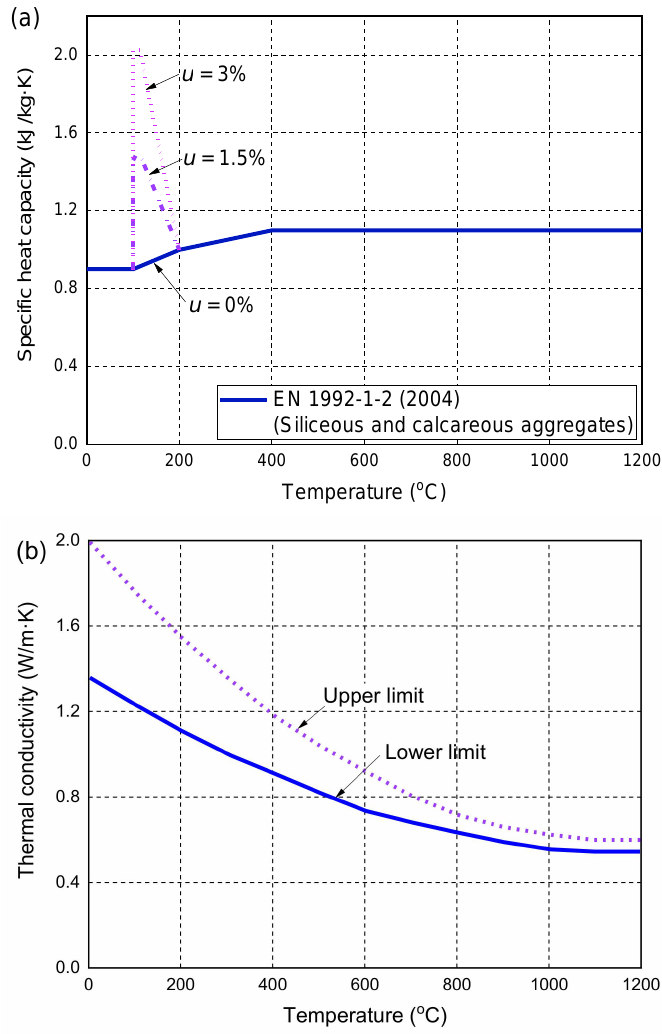
Figure 1. Thermal properties of concrete at high temperatures: ( a ) specific heat capacity; ( b ) thermal